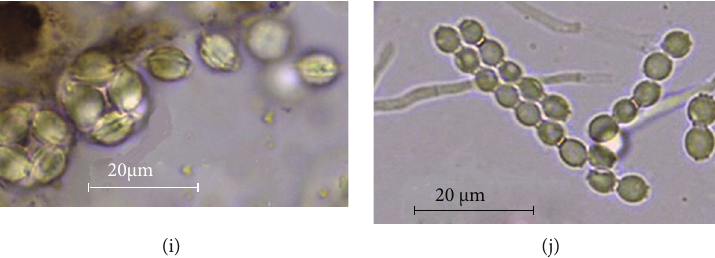
Figure 2: Seven-day fungal growth on media (a) Czapek, (b) Sabouraud, (c) modi fi ed agar medium #2 Gause, and (d) mineral agar medium #1 Gause; (e) cleistothecia on Sabouraud medium after 4 days of growth; (f) conidiophores on Sabouraud medium with 40% of glucose after 21 days of growth, upper part of the colony; (g) destroyed cleistothecia and asci; (h) conidiophore with single-row phialides covering the conidiophore ’ s head and chains of conidia; (i) asci and ascospores; (j) chains of conidia separated by disjunctors. Table 2: Alignment of gene sequences of the strain Eurotium cristatum (anam. Aspergillus cristatus ) INA 01267 with DNA sequences from GenBank. DNA regions/genes Species Alignment (%) Sequence length (b.p.) Sequence number in